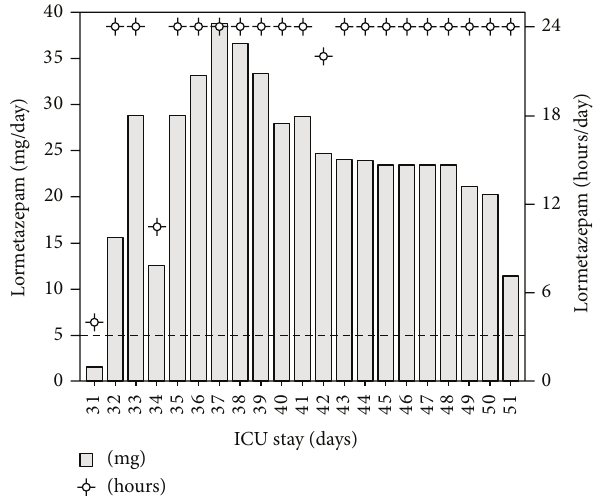
Figure 2: Duration and amount of intravenous administered lormetazepam per day. mg = milligram.